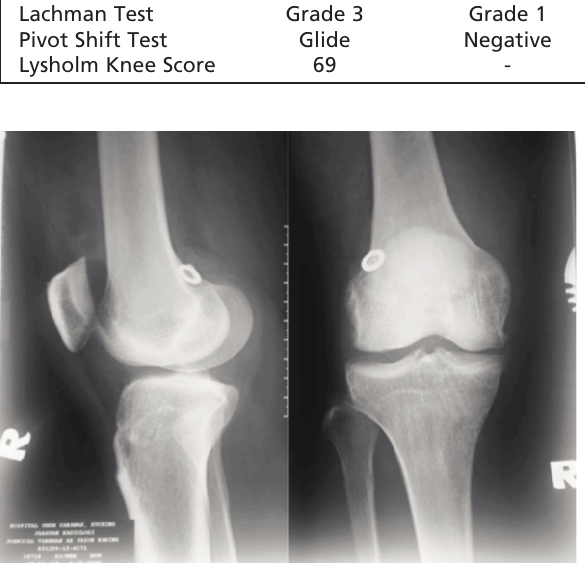
Post-operative radiographs of right knee showing Fig. 1: placement of the endobutton and washer over the lateral femoral wall.